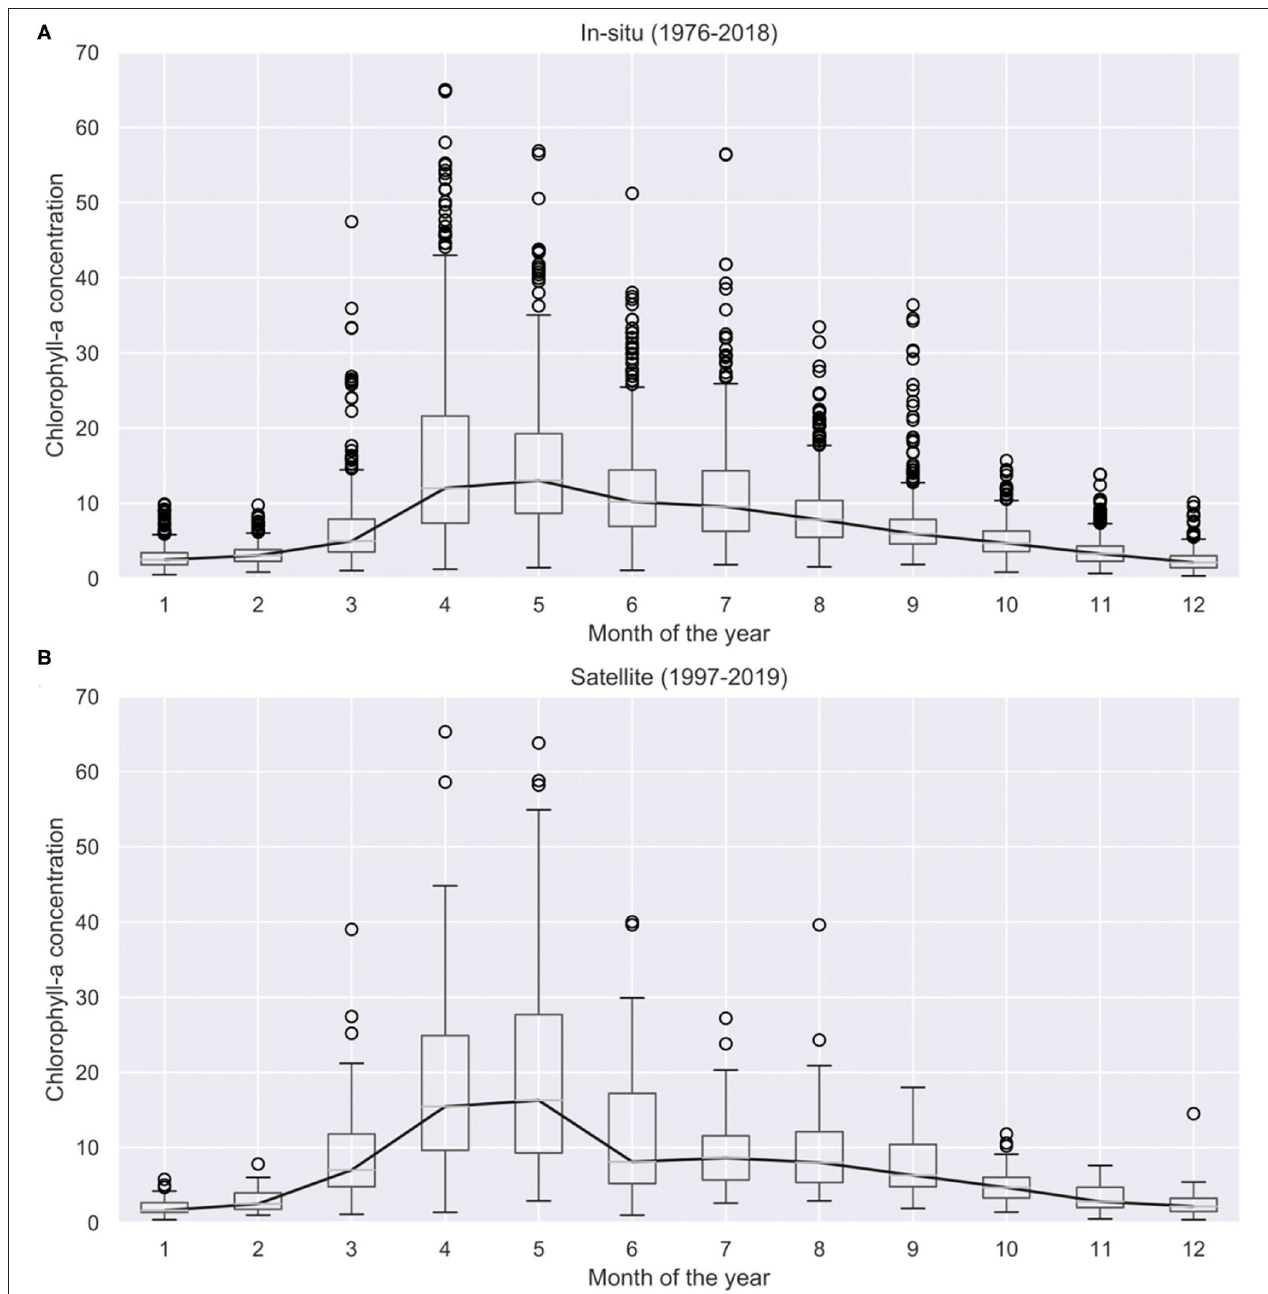
FIGURE 4 | Historical chlorophyll-a concentrations measured in the Dutch Wadden Sea using in-situ data between 1976 and 2018 (A) and satellite images between 1997 and 2019 (B) . Climatological median (solid black line) per calendar is also shown.